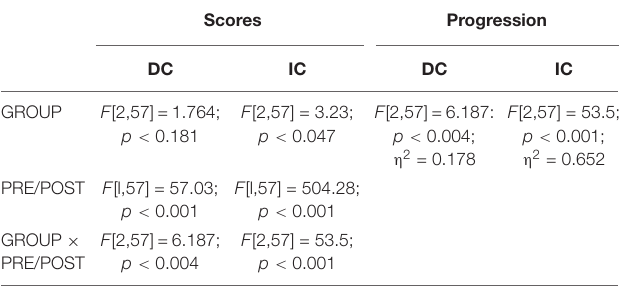
TABLE 5 | Results of the ANOVAs for the direct and indirect communications scores, and for the changes in direct and indirect communications between the PRE and POST measures